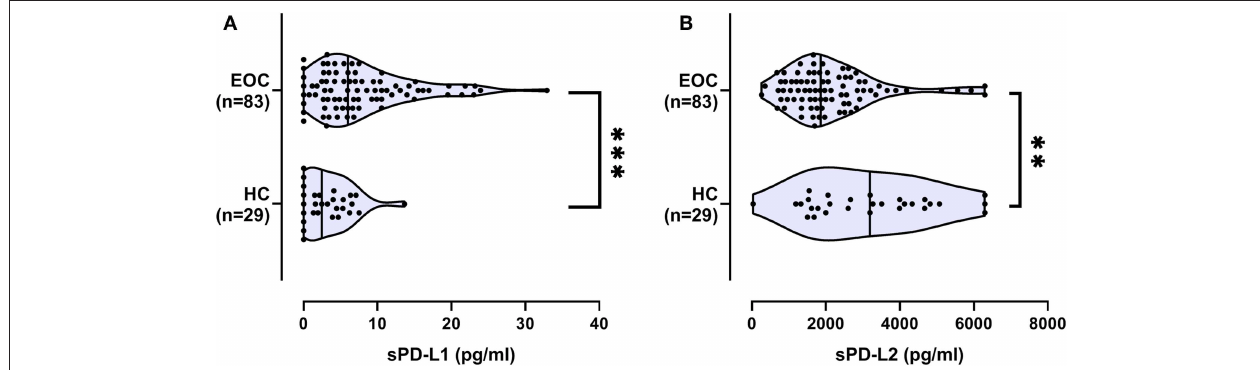
FIGURE 1 | Serum levels of sPD-L1 (A) and sPD-L2 (B) in healthy controls (HC) and ovarian cancer patients (EOC). Straight line within the violin plot indicates the median. ** p < 0.01, *** p < 0.001.